Question: Summarize what this figure shows in one sentence.
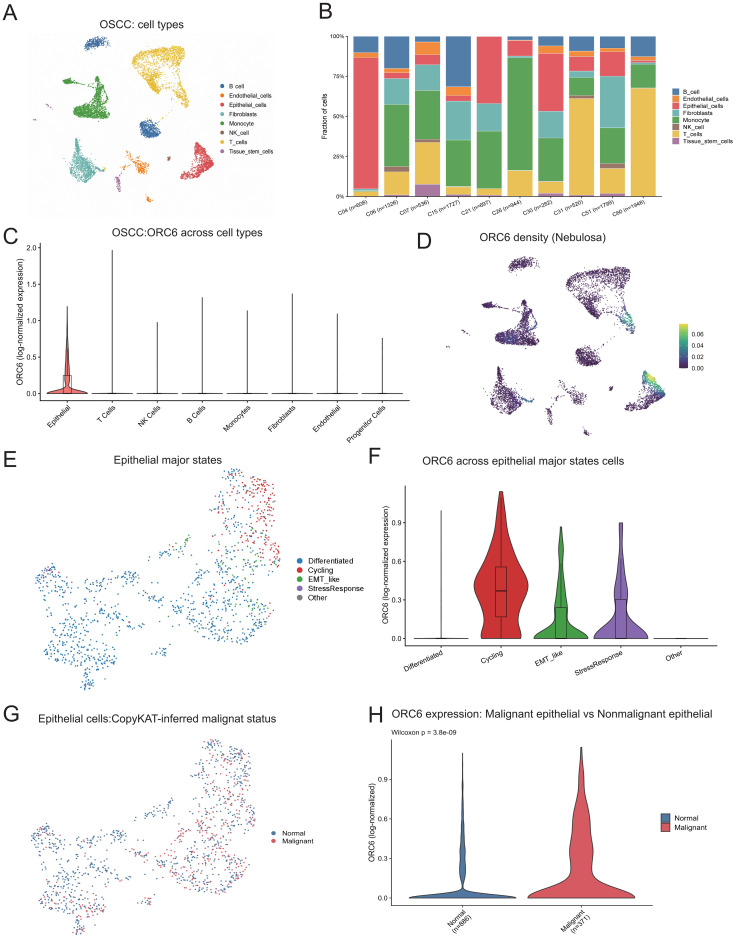
Answer: Single-cell mapping localizes ORC6 to malignant epithelium. (A) UMAP of major cell types in the OSCC microenvironment. (B) Cell-type composition across samples. (C) ORC6 expression across major cell types. (D) Nebulosa density map of ORC6 expression. (E) UMAP of major epithelial program states, including differentiated, cycling, EMT-like, and stress-related states. (F) ORC6 expression across epithelial program states. (G) CopyKAT-inferred malignant and nonmalignant epithelial cells. (H) Comparison of ORC6 expression between malignant and nonmalignant epithelial cells.